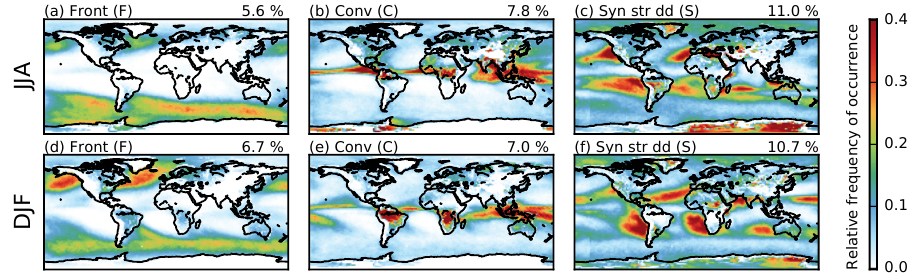
Figure 3. The relative frequency of occurrence for three of the regimes (frontal, convective and synoptic – strong downdraught) for the boreal summer (a–c) and winter (d–f) over a 10-year period (2003–2013). The frequencies are normalised so that they sum to one in each grid box. The latitude weighted mean RFO for each regime is shown at the top right for each